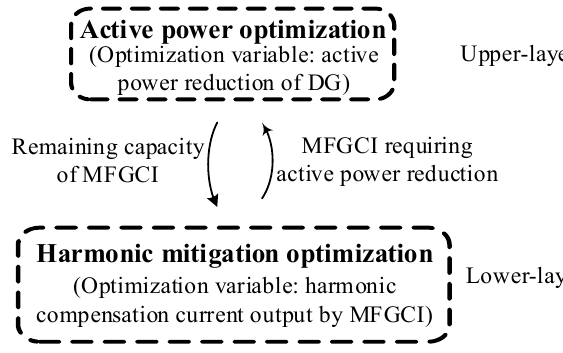
Figure 1. Optimization strategy.